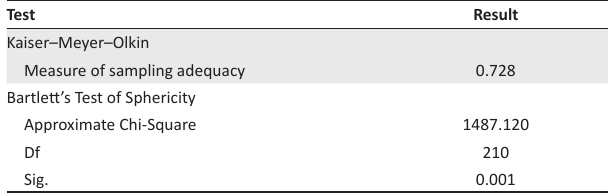
TABLE 3: Kaiser–Meyer–Olkin and Bartlett’s